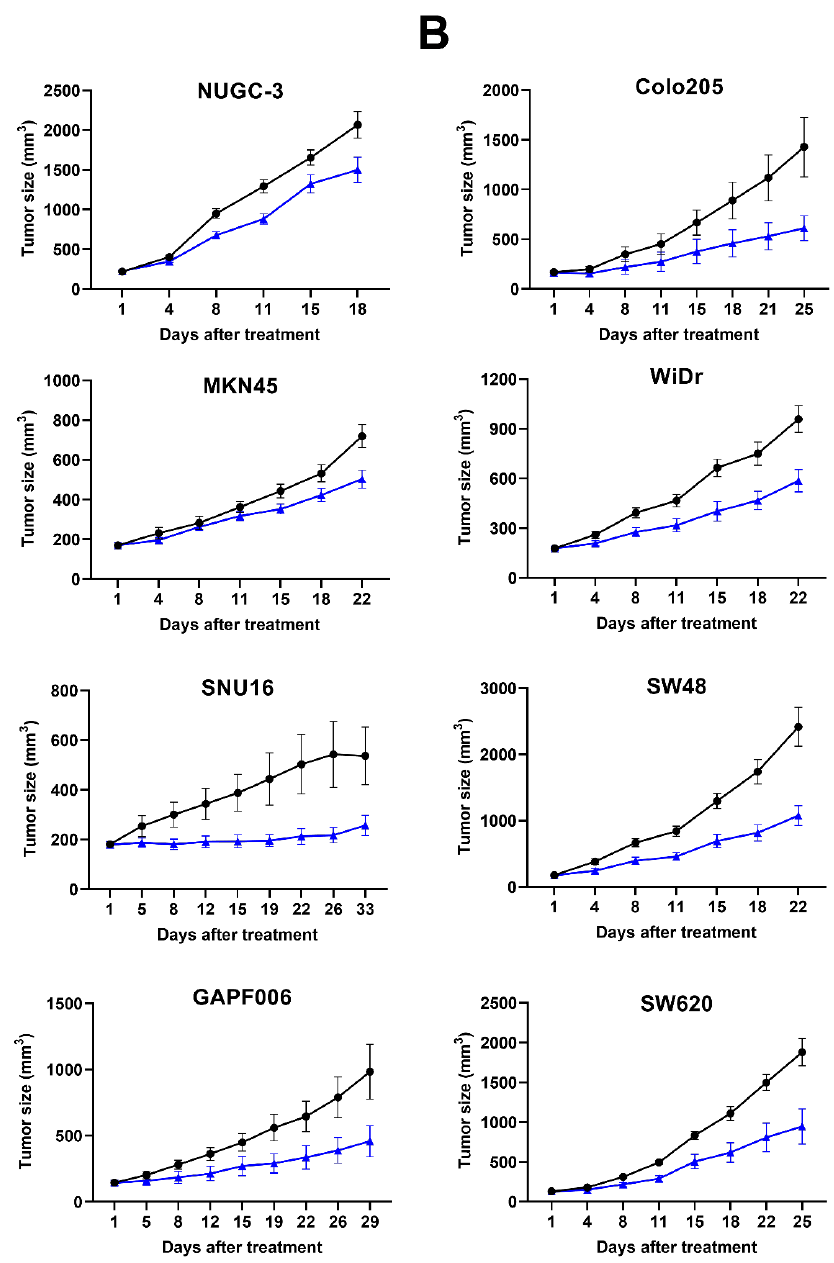
Figure 1. ABL001 strongly inhibited tumor progression of various human gastric and colon cancer xenograft models. Tumor size was measured twice per week and compared between vehicle (closed circle) and ABL001 (closed triangle) in human gastric cancer (NUGC-3, MKN45, SNU16 for mABL001, and human patient-derived gastric cancer GAPF006 for ABL001) xenograft model ( A ) and human colon cancer (Colo205, WiDr, SW48, SW620 for mABL001) xenograft model ( B ). ABL001 treatment significantly delayed tumor progression in different cancer xenograft models compared to control group of vehicle treatment. Error bars: mean ± SEM.